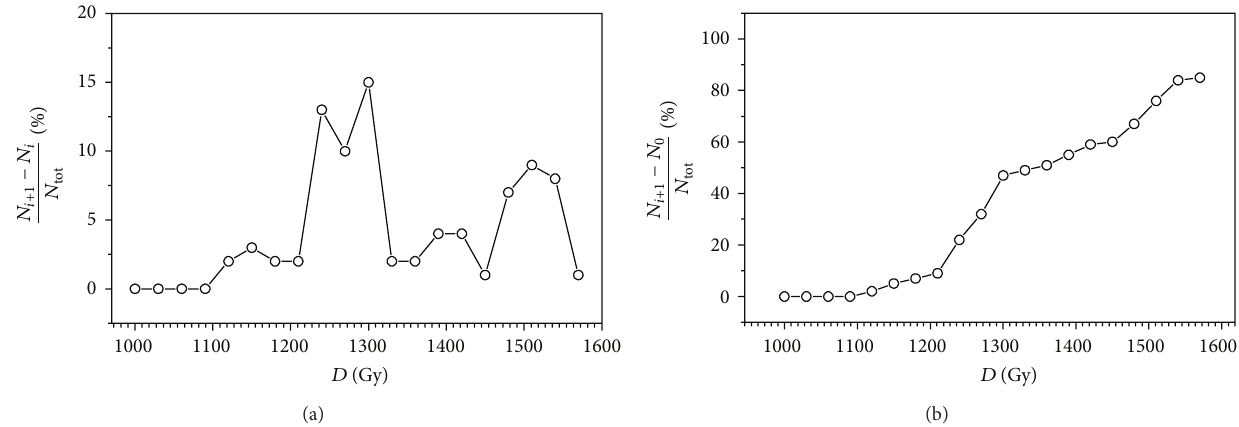
Figure 1: The average relative change in number of errors in irradiated EPROM samples (NM27C010) versus the absorbed dose of radiation: (a) differential; (b) cumulative ( 𝑁